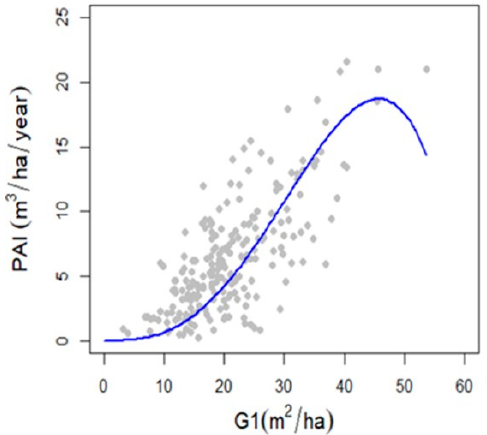
Figure 5. Assumed relation between basal area and production based on our data.